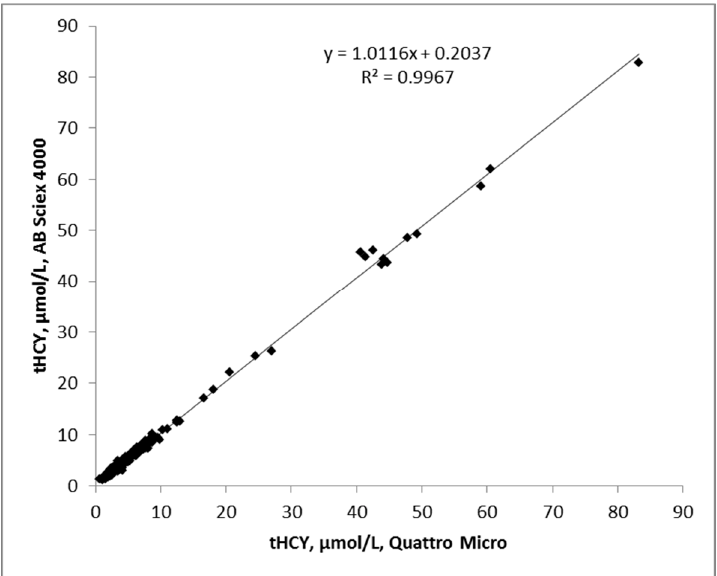
Figure 3. Comparison of tHCY results for dried blood spots (DBS) samples ( n = 300) analyzed on Quattro Micro and AB Sciex 4000 instruments.